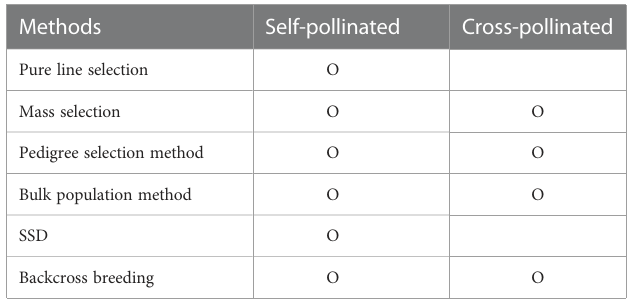
TABLE 1 Comparison of breeding methods according to pollination of